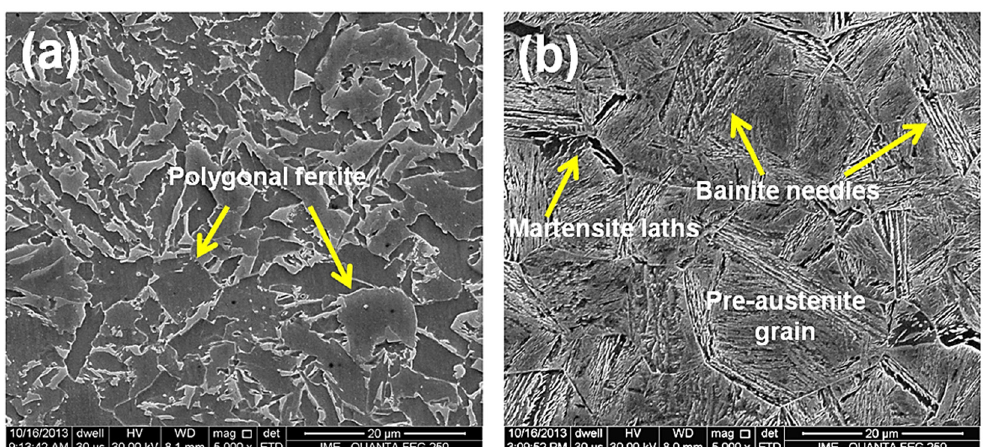
Figure 9 . SEM micrographs of the higher heat input welded joint, in the regions ( a ) FZ and ( b ) HAZ.